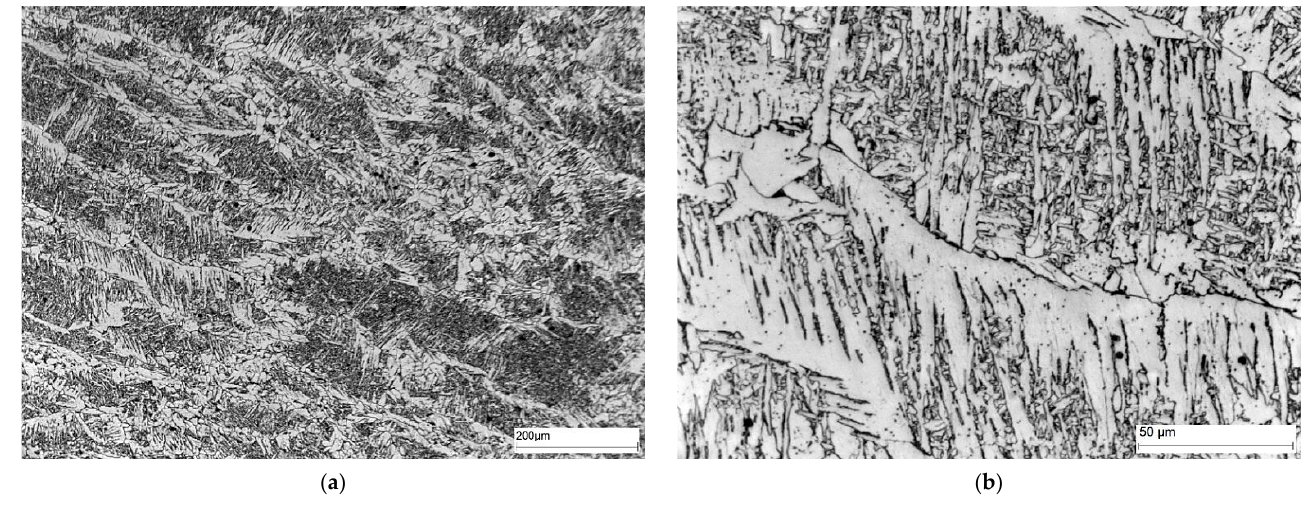
Figure 17. Microstructure of area D—weld: ( a ) 100× magnification, and ( b ) 500× magnification. Widmanstätten ferrite—white precipitates with different morphology, quenching products, mainly bainite—dark precipitates.